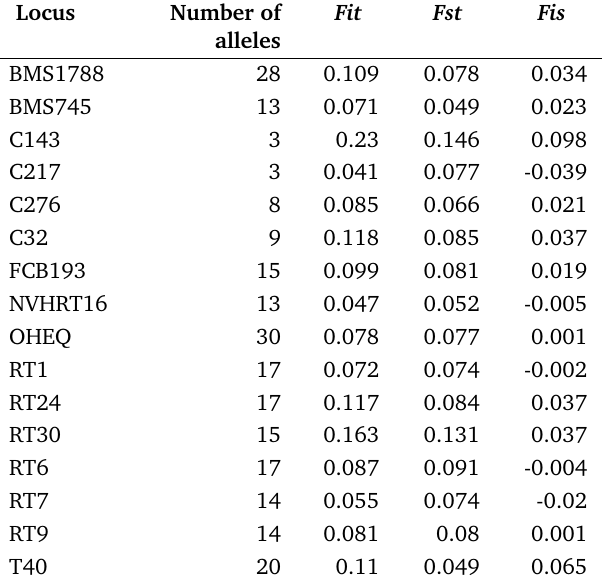
Table 4. Wright’s F statistics for each locus. Fit : the inbreeding coefficient of an individual relative to the entire population; Fst : the inbreeding coefficient of the subpopulation relative to the entire population expected under random mating; Fis : the inbreeding coefficient of an individual relative to its own